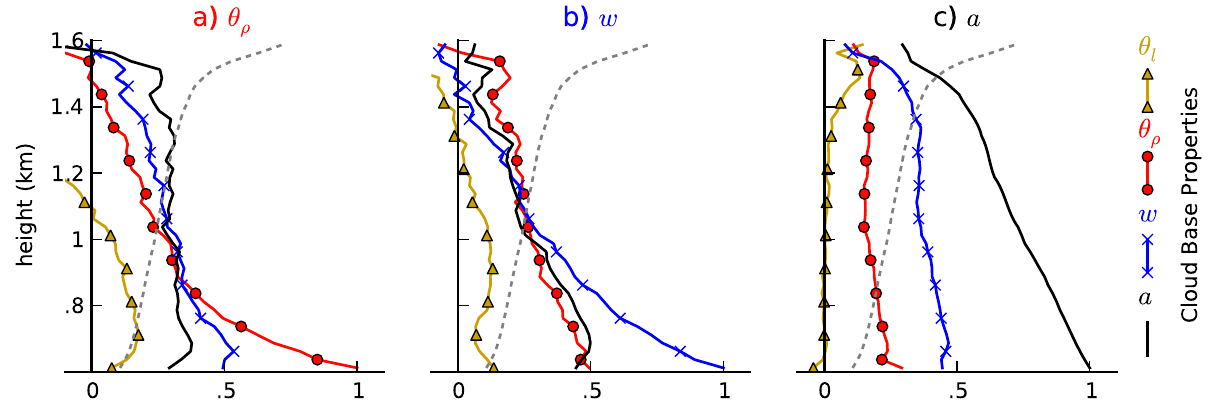
Fig. 12. Correlation profiles between cloud base properties at 600m and at higher levels for (a) density potential temperature θ ρ , (b) vertical velocity w , and (c) horizontal cross-sectional area a . Yellow triangles show correlations with cloud base θ l , red circles show correlations with cloud base θ ρ , blue x markers correlations with cloud base w , and the black line show correlations with cloud base a . Dotted lines show the 99% confidence level for a correlation to be significantly different than zero.